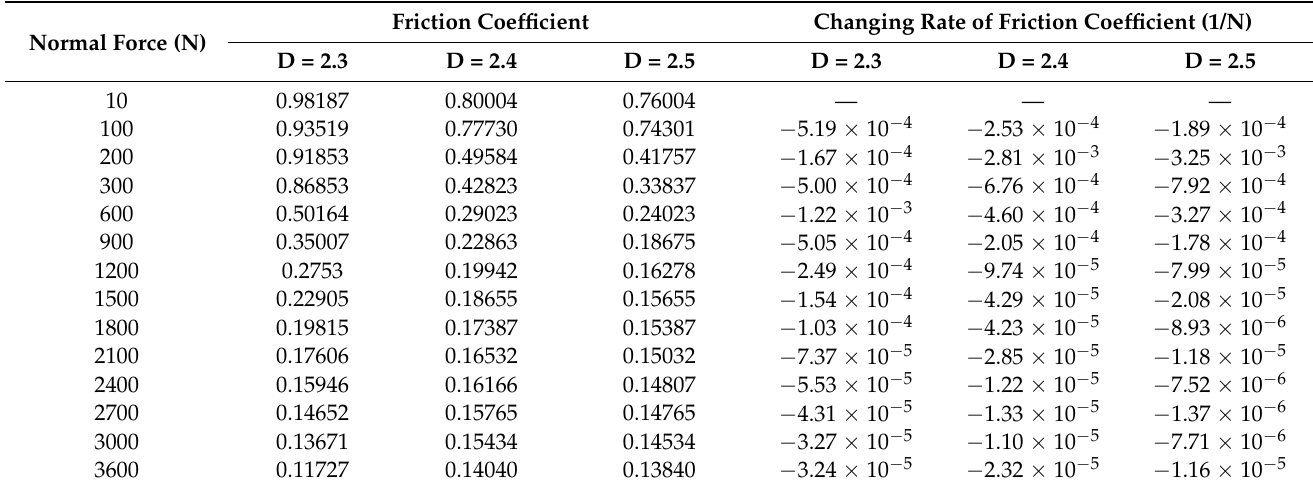
Table 2. Simulation results of the friction coefficient for different normal forces and fractal